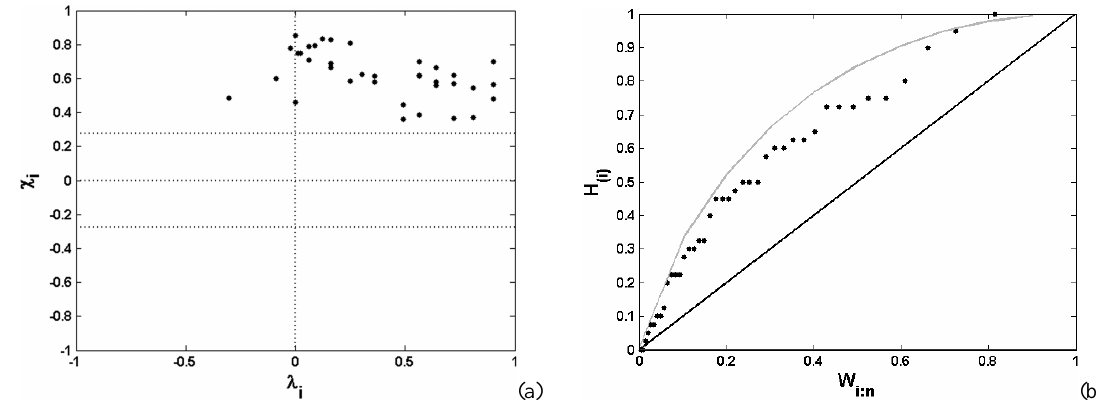
Fig. 4. (a) Chi-Plot and (b) K-plot.